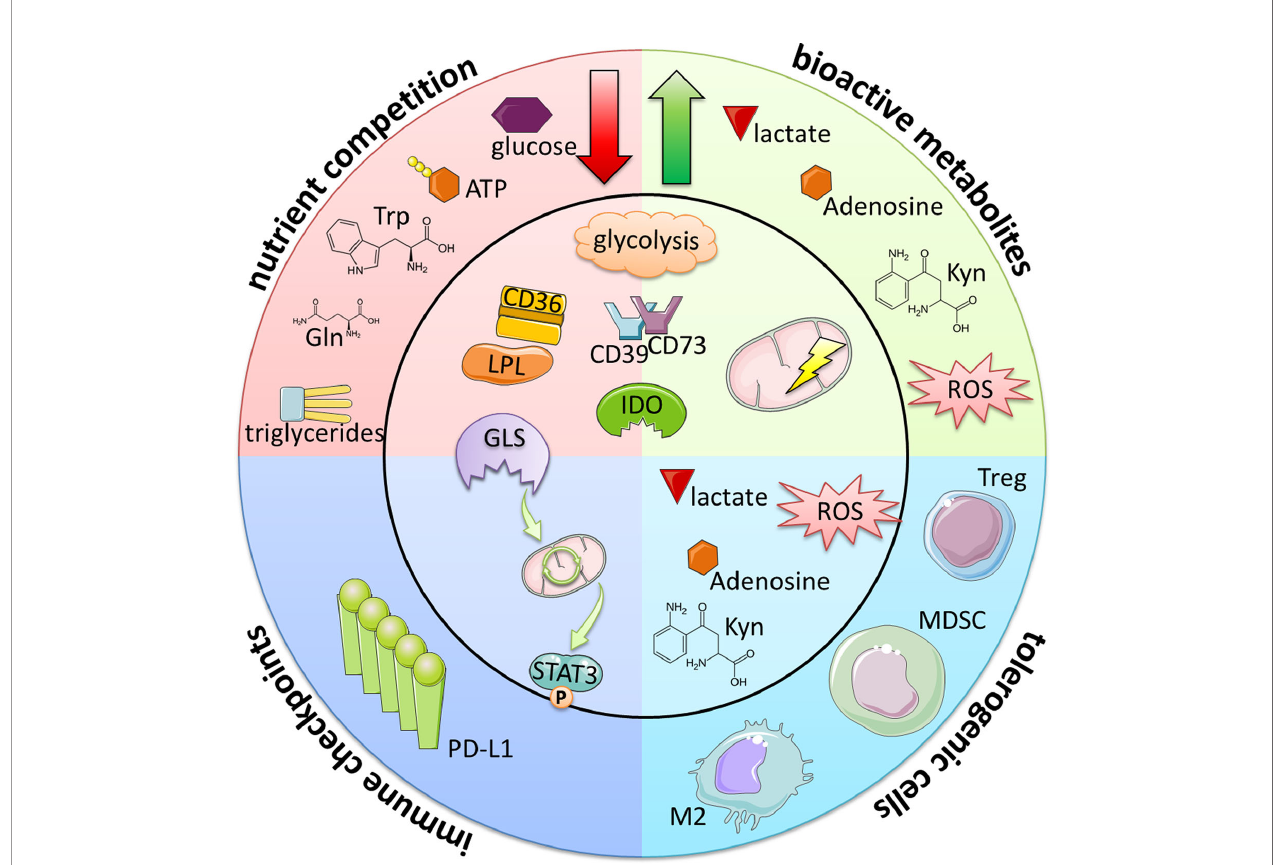
FIGURE 2 | Immunometabolic evasion mechanisms of B-cell lymphomas and CLL. Metabolic alterations lead to the reduction of essential immune cell nutrients and at the same time to the generation of bioactive metabolites. In addition to their direct immuno-suppressive nature, these byproducts also increase the frequencies of tolerogenic, suppressive immune cells (such as Tregs, myeloid-derived suppressor cells [MDSCs] and M2-like macrophages) either indirectly via the creation of favorable conditions or directly inducing their differentiation. Furthermore, certain metabolic programs can promote the expression of immune checkpoints such as PD-L1. Taken together, these events ultimately lead to the overall suppression of immune attack and increase the tumor cells ’ survival and